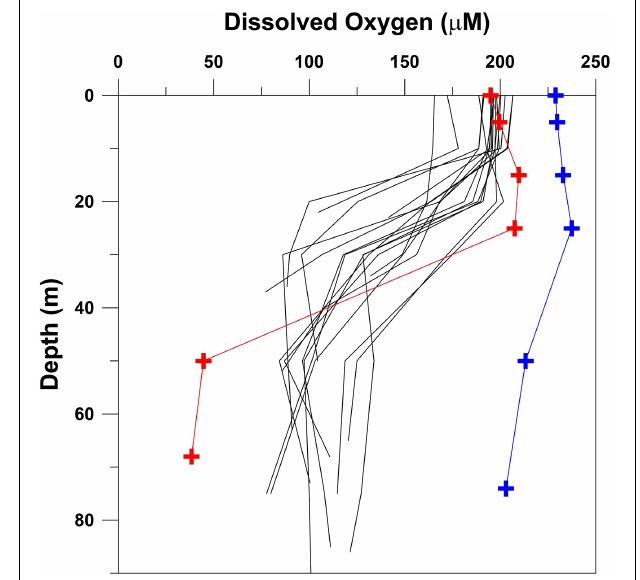
FIGURE 6 | Comparison of oxygen profiles generated by two Argo floats deployed in the Red Sea north of ∼ 23 ◦ N latitude: #6901573 from September 29, 2015 to February 19, 2017 (black symbols) and #6901577 from September 30, 2015 to December 29, 2016 (blue symbols) with the Winkler oxygen data (red circles) collected during the May 1983 cruise of R.V. Sagar Kanya ( Figures 1A , 2 ).